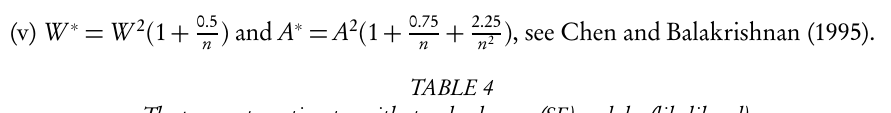
The parameter estimates with standard error (SE) and -log(likelihood).